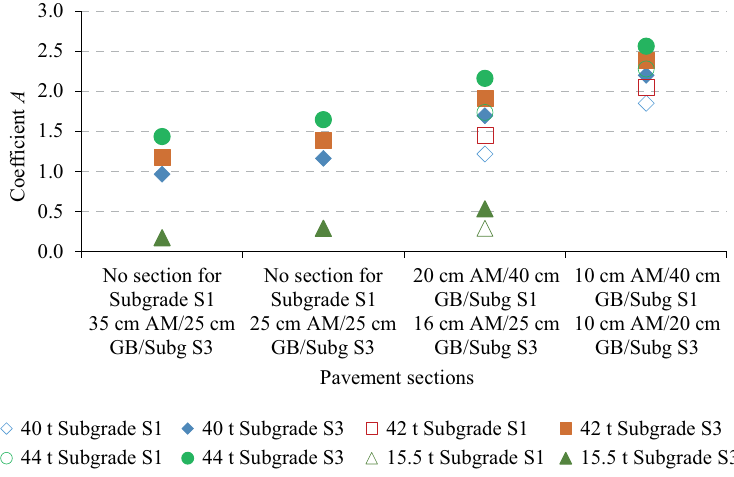
Figure 3. Aggressiveness coefficient for a heavy vehicle on flexible pavements